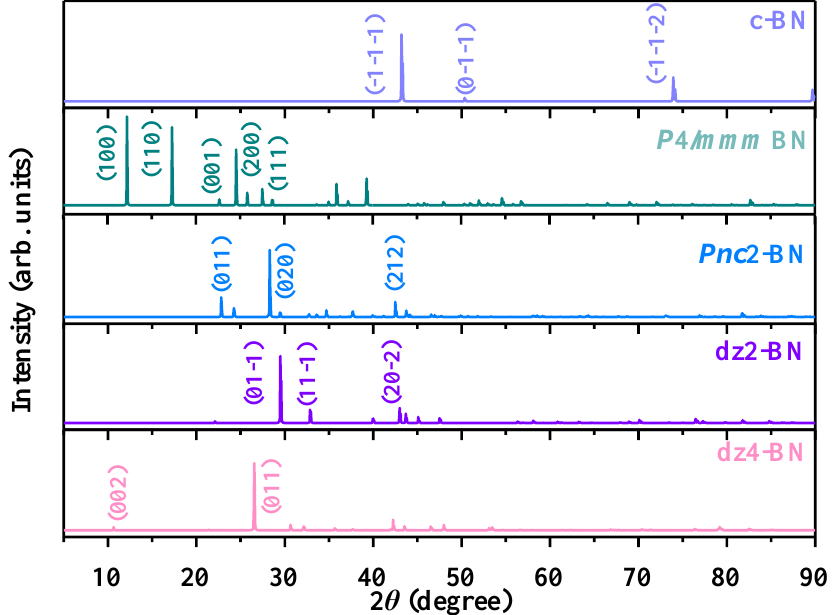
Figure 8. Simulated XRD patterns of P 4/ m BN using an X -ray wavelength (1.5406 Å ) with a copper source.